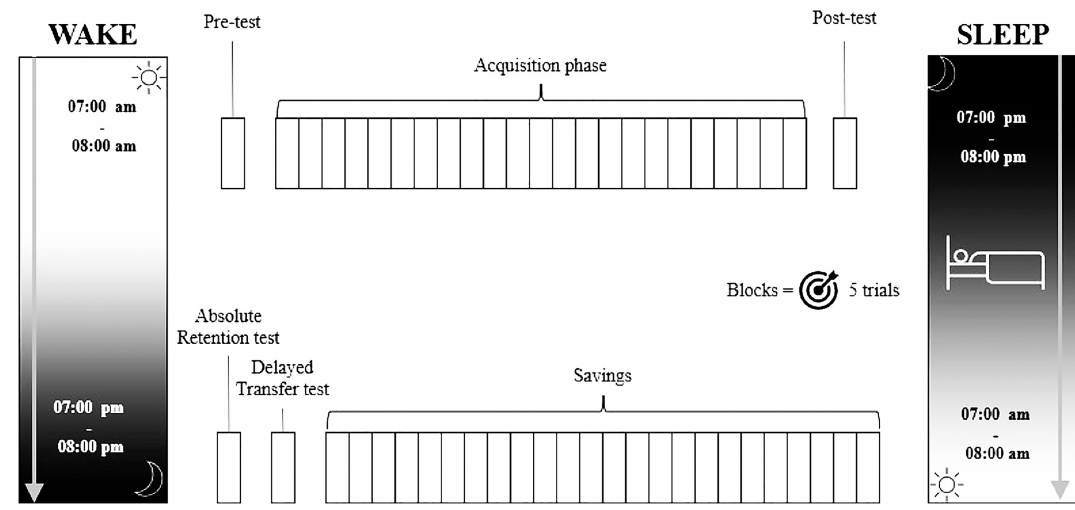
Figure 1 - Experimental design